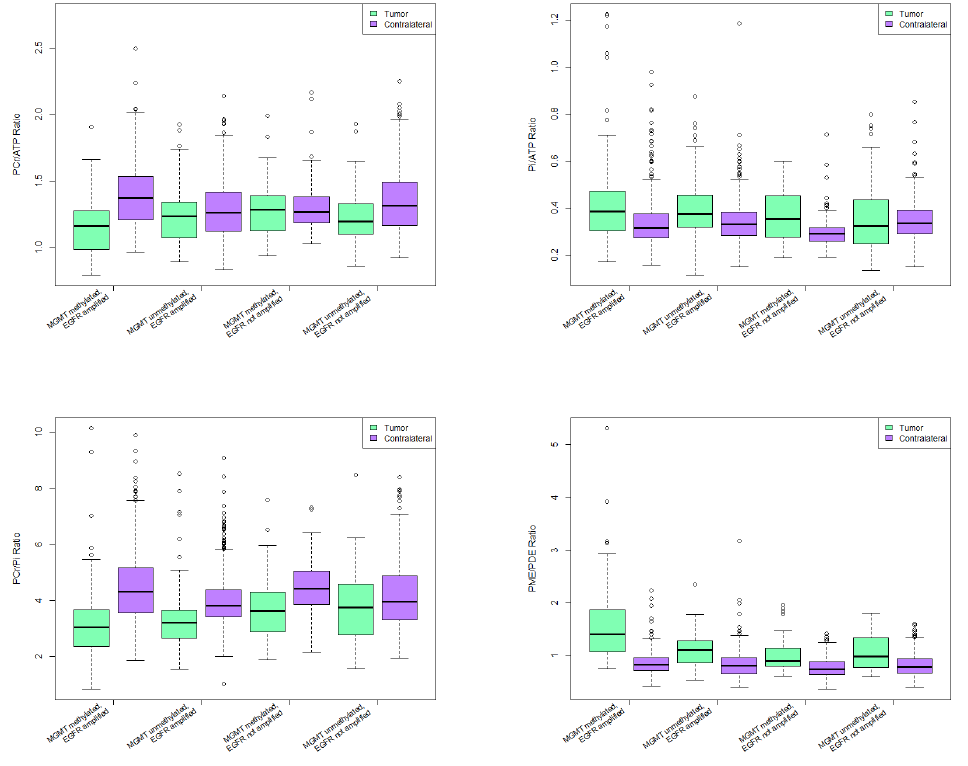
Figure 5. 31-P-MRS ratios in various combinations of molecular